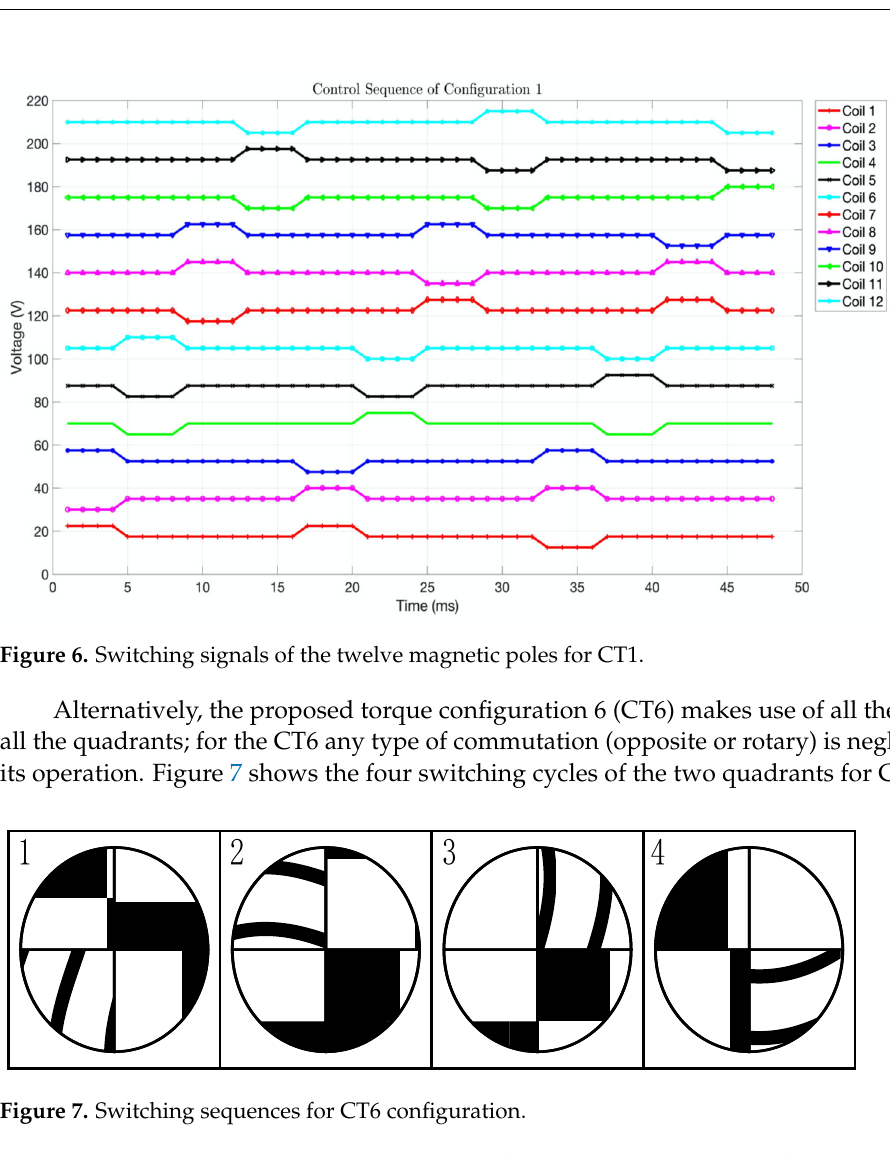
Figure 5. Switching sequences for CT1 configuration.